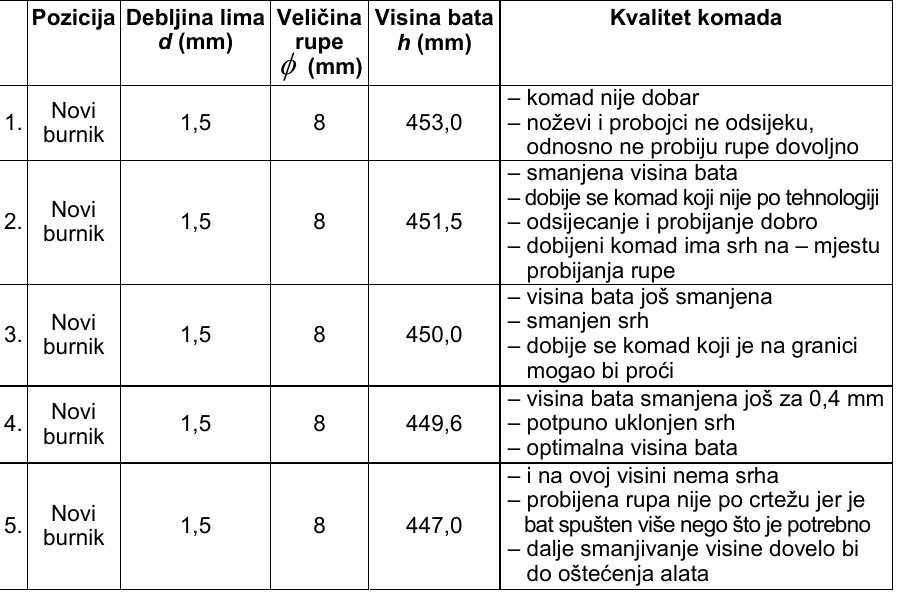
Table1 – Experimental adjusting of the ram height for the “Novi Burnik” position Pozicija Debljina lima d